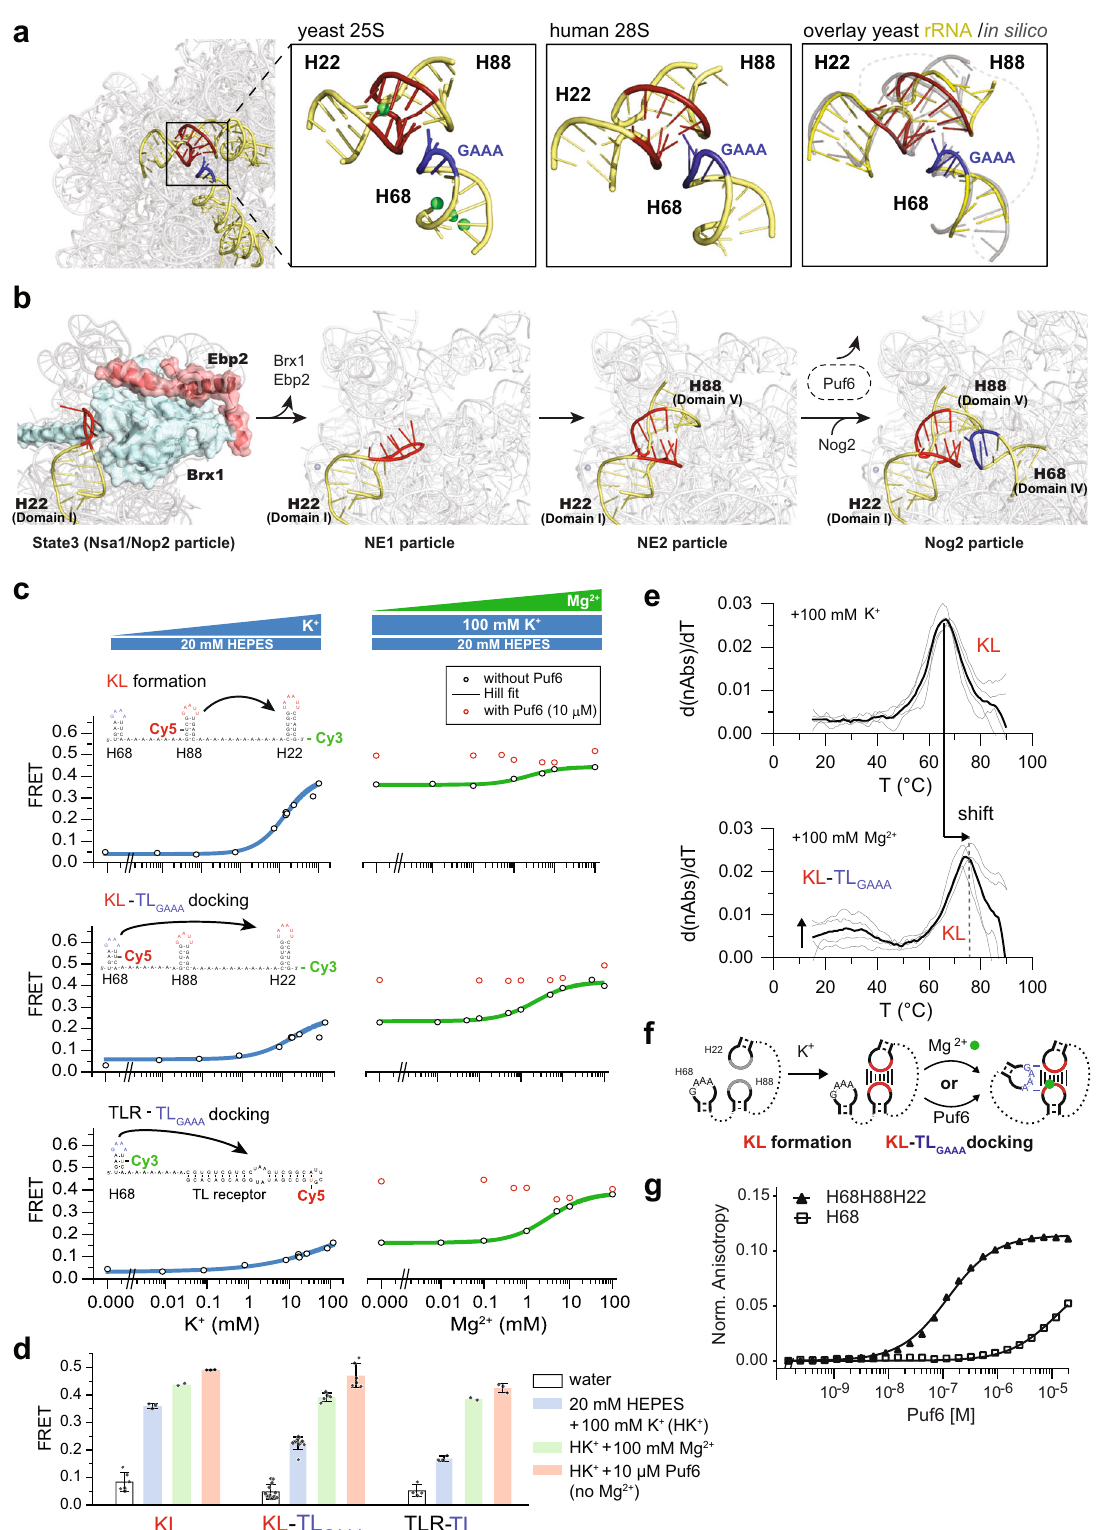
negative charges of the rRNA backbone to establish correct ter- tiary interactions between fl exible rRNA helices, prior to fi nal stabilization by Mg 2 + 12,47 . Puf6 interacts only with H68, but not with isolated H22 and H88 in vivo (Supplementary Fig. 4) sup- porting the idea that Puf6 ushers H68 docking onto a pre-formed H22-H88